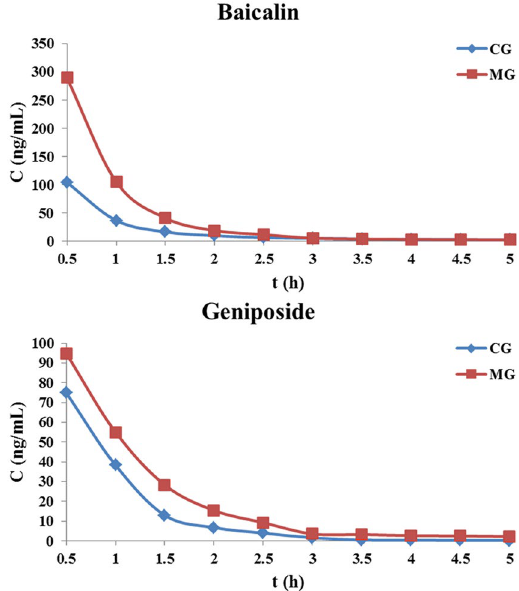
Figure 2. Hypothalamus microdialysis concentration-time profiles of baicalin and geniposidein in CG and MG rats after intravenous administration of QKLI.